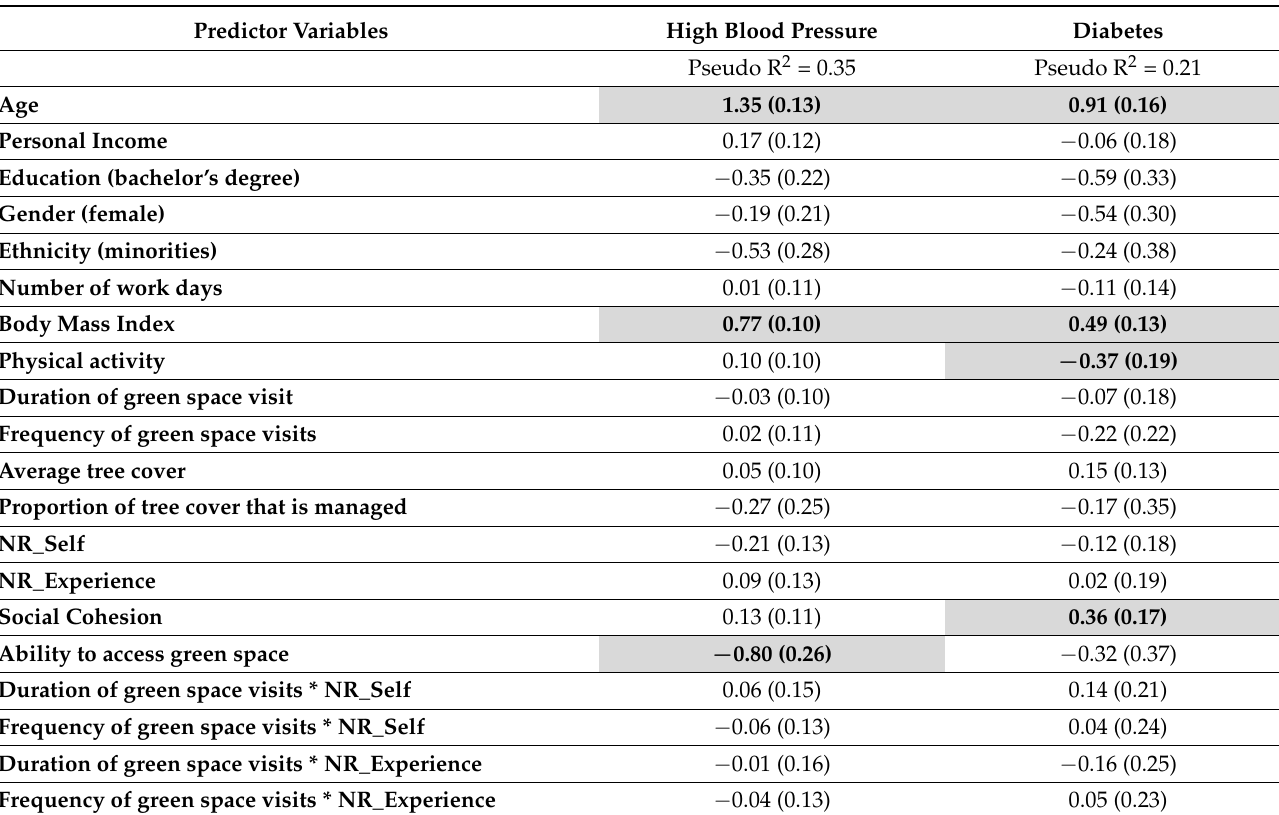
Table 3. The relationship between physical health outcomes (high blood pressure and diabetes), socio-demographic covariates, and nature exposure predictor variables. The Nagelkerke/Crag and Uhler’s pseudo R 2 and estimated parameter coefficients are presented from the negative binomial GLMs, with standard error in brackets. Table cells shaded in grey (with bold numbers) represent significant predictor variables ( p -value ≤ 0.05). An asterisk represents an interaction between two predictor